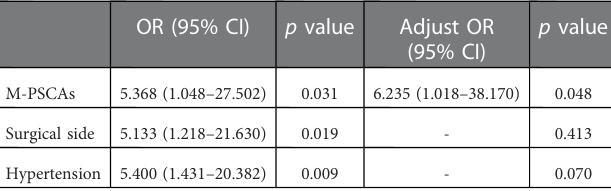
( Table 5 : M-PSCAs, 26.4 ± 7.2 μ m; non-M-PSCAs, 29.5 ± 7.3 μ m, p = 0.087).